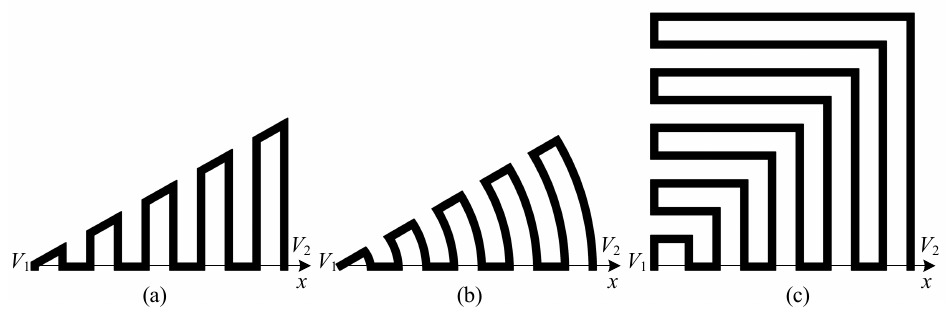
Figure 2. Several electrode patterns to form a parabolic voltage distribution. ( a ) triangle, ( b ) fan ‐ shaped, and ( c ) rectangle.